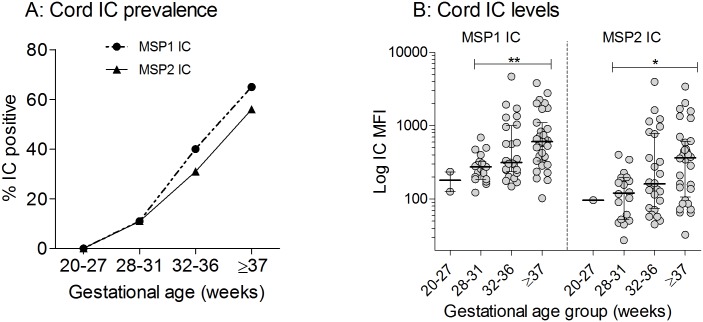
Timing of fetal exposure to maternal immune complexes (IC).Peripheral plasma samples of 77/242 mothers had IC containing MSP1 or MSP2. Cord plasma IC data of the 77 corresponding newborns were analyzed for materno-fetal IC transfer. (A) The percentage of cord blood samples with IC increased with GA, especially after 31 wks. (B) Average levels of Pf-specific IC in cord plasma. P values were calculated using Kruskal-Wallis test with post-test for trend: *p<0.01 and **p<0.001. The 20–27 wks group was excluded in the analysis because of few (<3) data points.